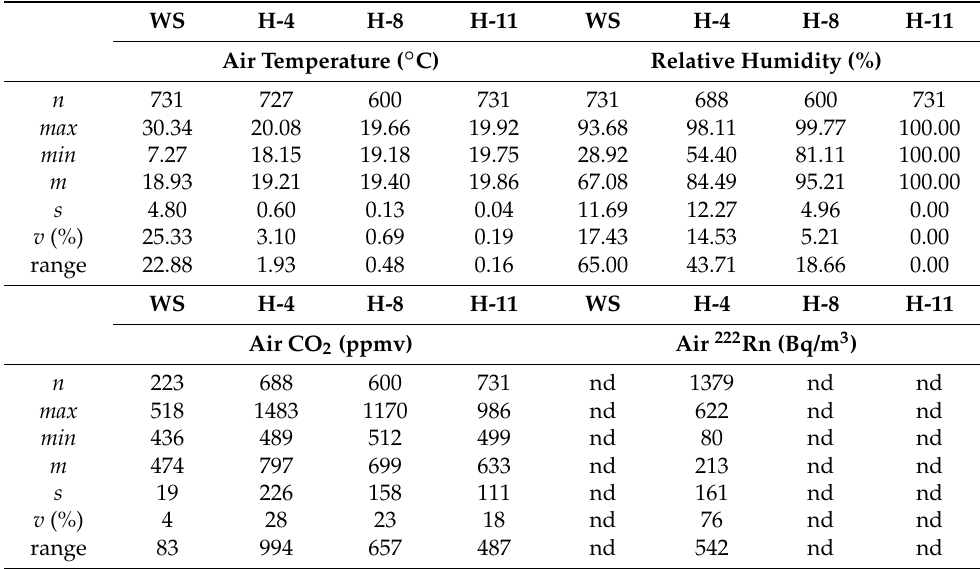
Table 1. Microclimatic data registered in Nerja Cave, Spain, and the exterior atmosphere during 2016 and